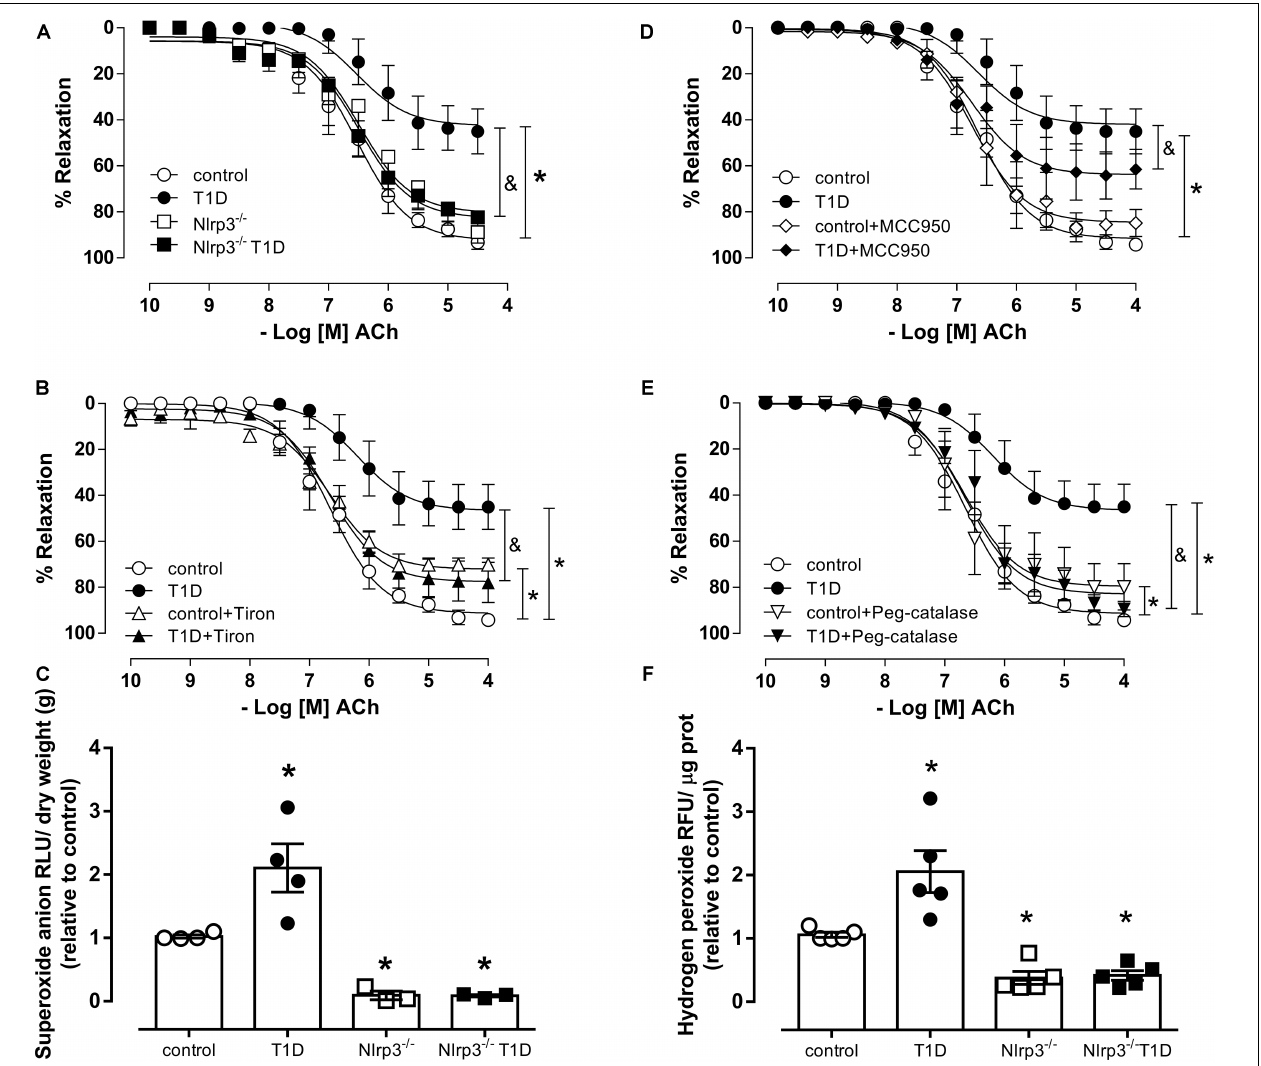
FIGURE 2 | Cumulative concentration-response curves to Acetylcholine (ACh) (A) , endothelium-dependent vasodilator, in resistance mesenteric arteries from C57BL/6 non-diabetic (control, white circles) or diabetic (T1D, black circles) and Nlrp3 − / − non-diabetic ( Nlrp3 − / − , white squares) or diabetic ( Nlrp3 − / − T1D, black squares) mice in the presence of (B) vehicle (white diamonds) and a NLRP3 inhibitor (MCC950, black diamonds), (C) vehicle (white triangles) and superoxide scavenger Tiron (black triangles), and (D) vehicle (white triangles down) and catalase mimetic peg-catalase (black triangles down). Generation of (E) superoxide anion and (F) hydrogen peroxide in mesenteric bed from non-diabetic (control, white circles) or diabetic (T1D, black circles) C57BL/6 mice and non-diabetic ( Nlrp3 − / − , white squares) or diabetic ( Nlrp3 − / − T1D, black squares) Nlrp3 − / − mice. Each point/column represents the mean ± SEM. ∗ P < 0.05 vs. control, & P < 0.05 vs. T1D. N = 3–7, two-way ANOVA followed by Tukey’s post hoc test (A–F) .